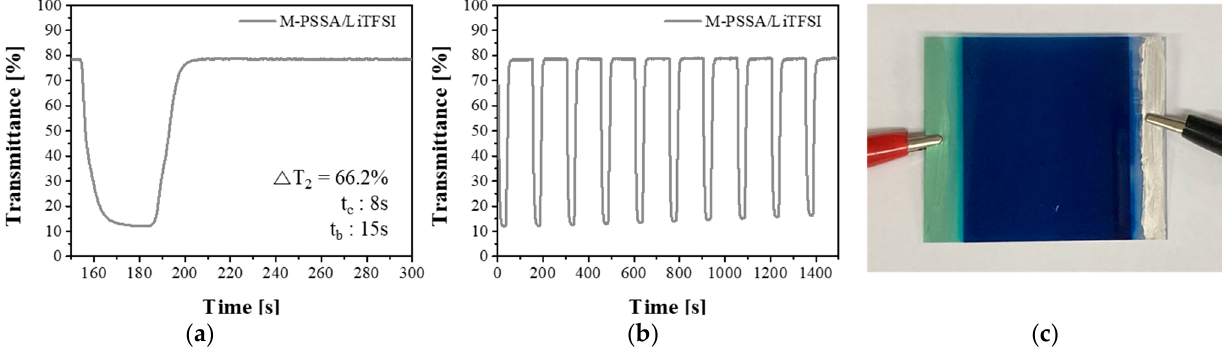
Figure 7. An optimized electrochromic device (ECD) and optical properties of the ECD. Applied square-wave potential between − 1.2 V (30 s) and 0.5 V (120 s). ( a , b ) Transmittance vs. time of ECD, ( c ) A photograph of colored ECD (5 × 5 cm 2 ).